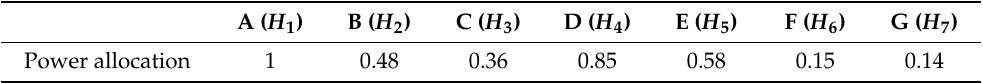
Table 1. Normalized power balance (NPB) for the i -MIMO